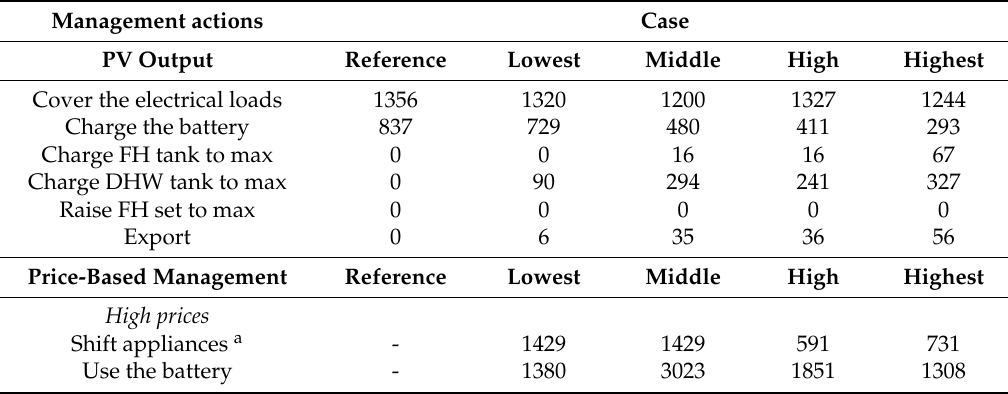
Table 6. The energy shifted in the simulated year, in kWh, by the energy management actions for the selected cases and for the reference